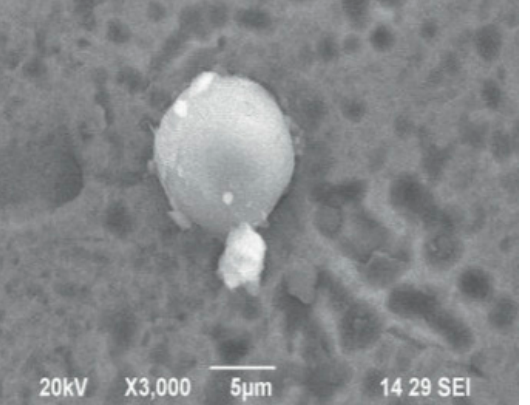
Figure 15. SEM micrographs of AA6061/fly ash compo cast composites containing 7.5 wt.% SiC–7.5 wt.% fly ash [93].